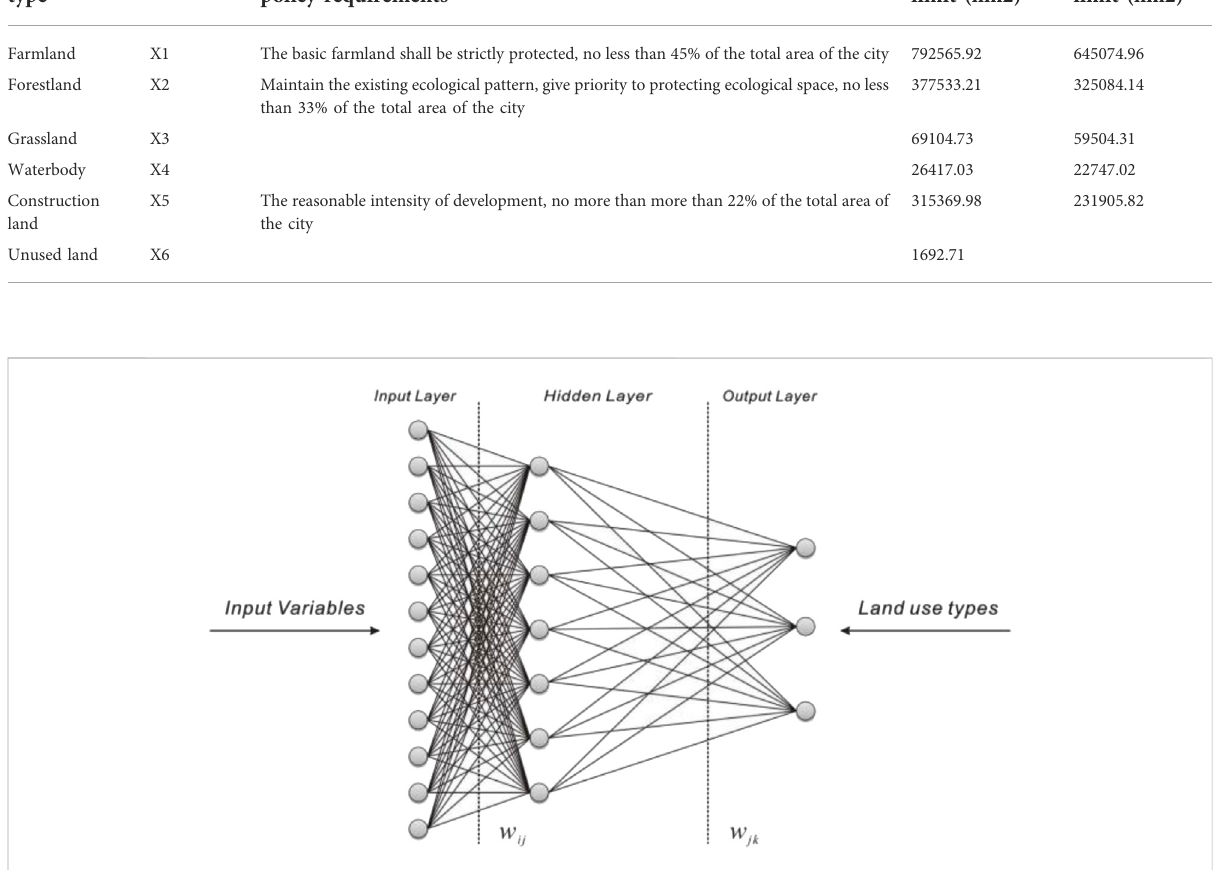
FIGURE 3 Basic structure of neural network in the FLUS model.